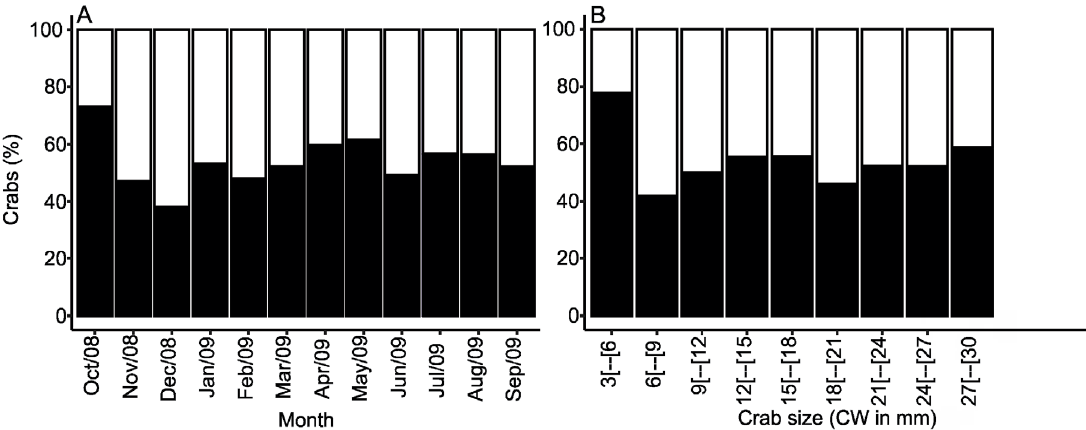
Figure 1. Proportion of females (white bars) and males (black bars) of Uca maracoani by ( A ) Month and ( B ) Crab size (CW in mm).